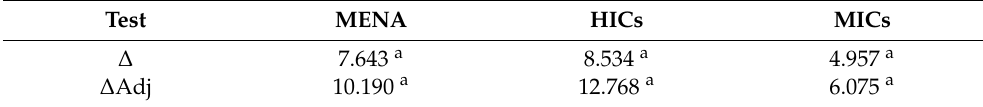
Table 6. Pesaran–Yamagata (2008) [74] Slope Homogeneity Results. Test